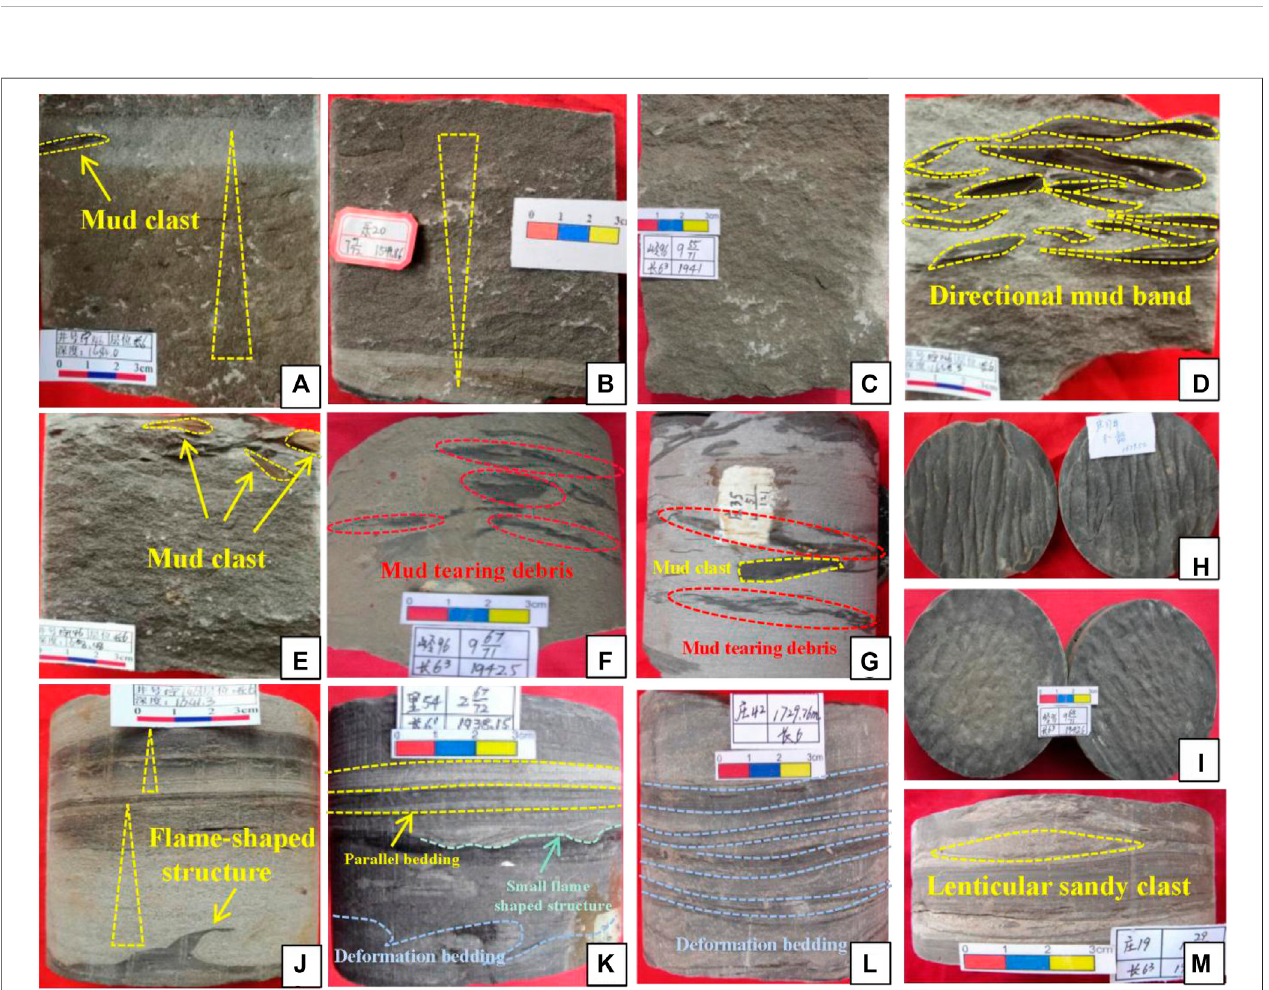
FIGURE 6 | Depositional characteristics of sandy debris fl ow and turbidity current on core.